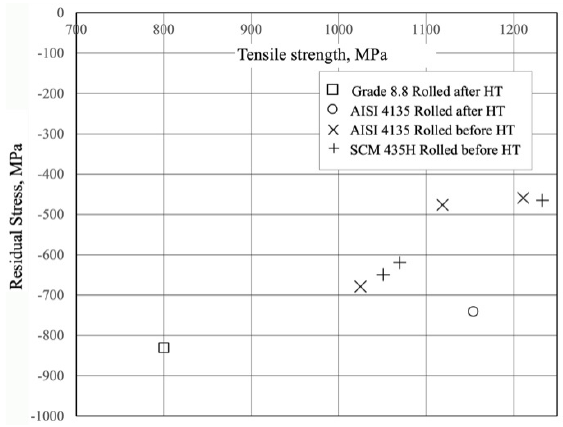
Figure 7. Residual stress vs Tensile